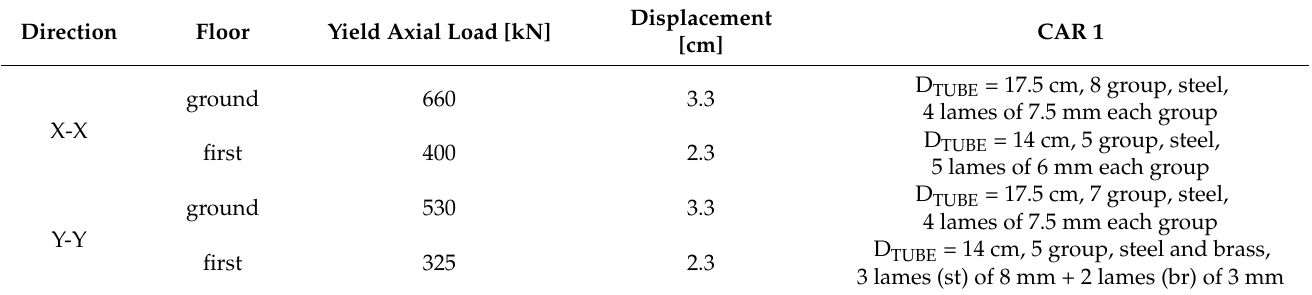
Table 3. Description of the selected characteristics of the CAR1 dampers for